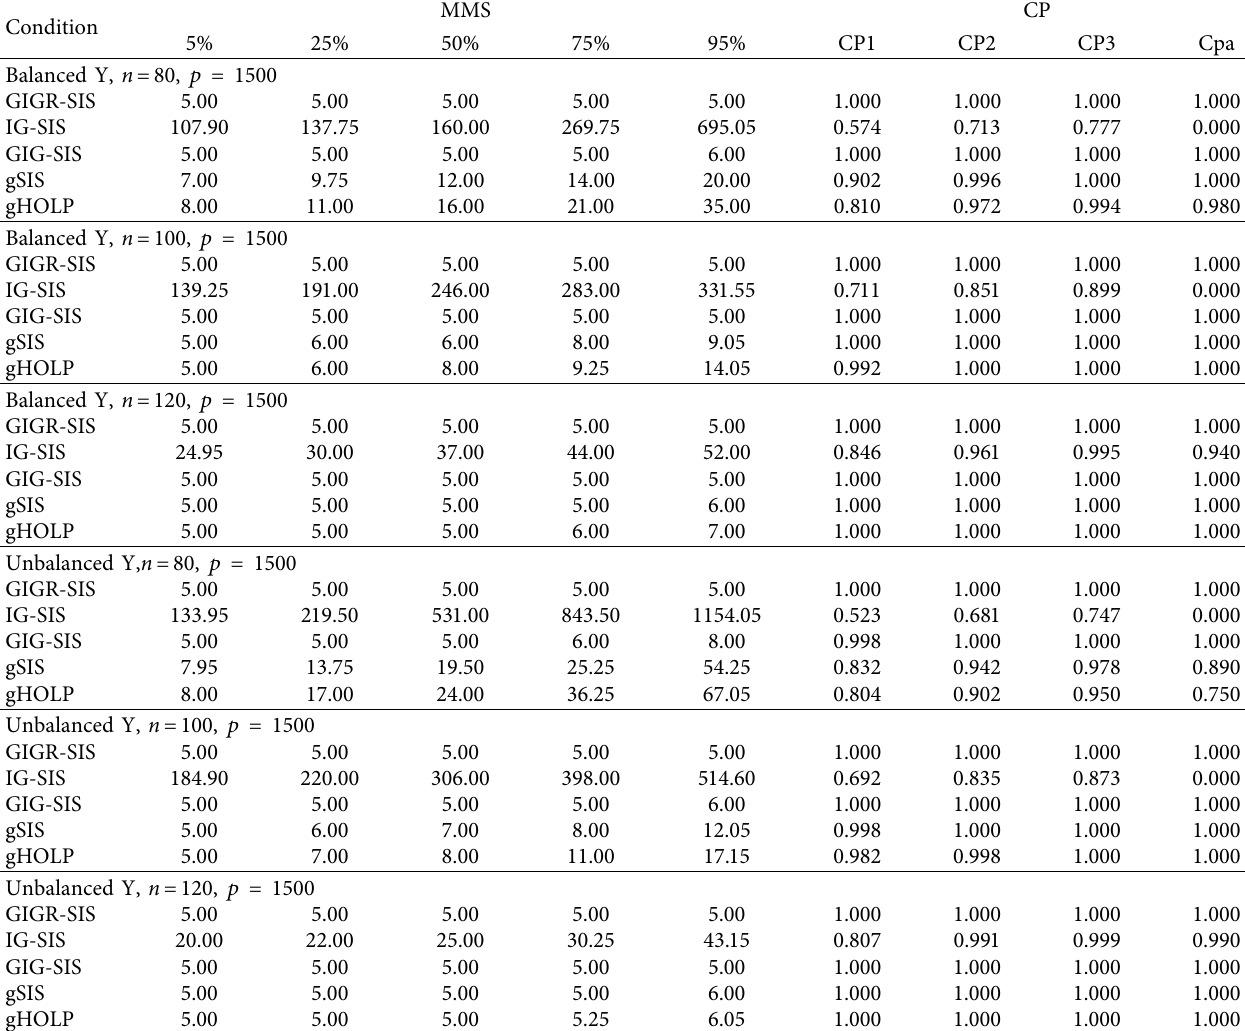
Table 1: Simulation results for Model